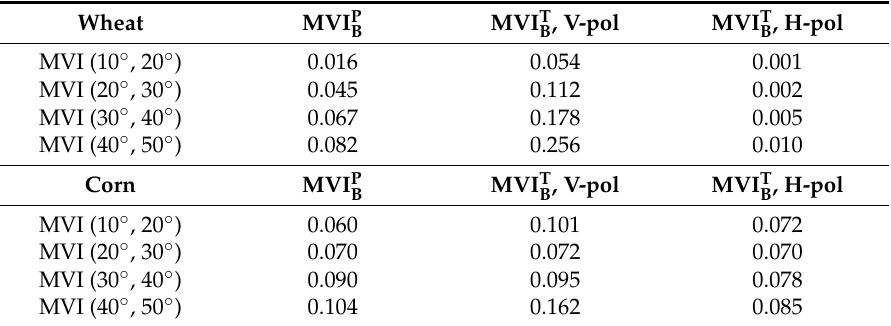
Table 2. The coefficient of variation value for microwave vegetation indices (MVIs) .